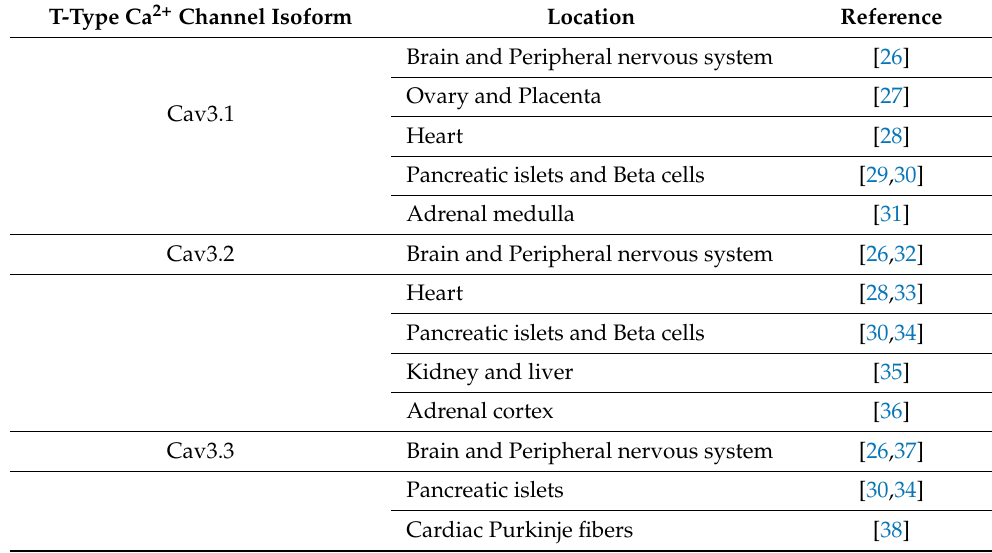
Table 1. Major location of T-type Ca 2+ channels.